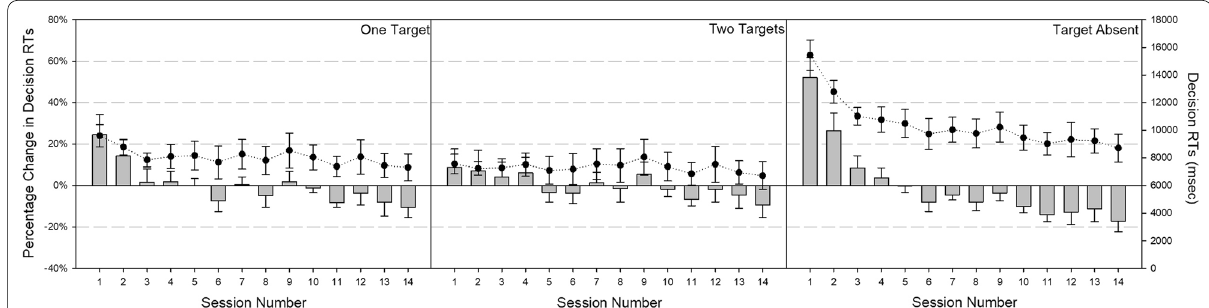
Fig. 5 Decision RTs (circles) and percent change in RT (bars) across sessions for one-target (left panel), two-target (middle panel), and target-absent (right panel) trials. Error bars reflect 1 standard ±